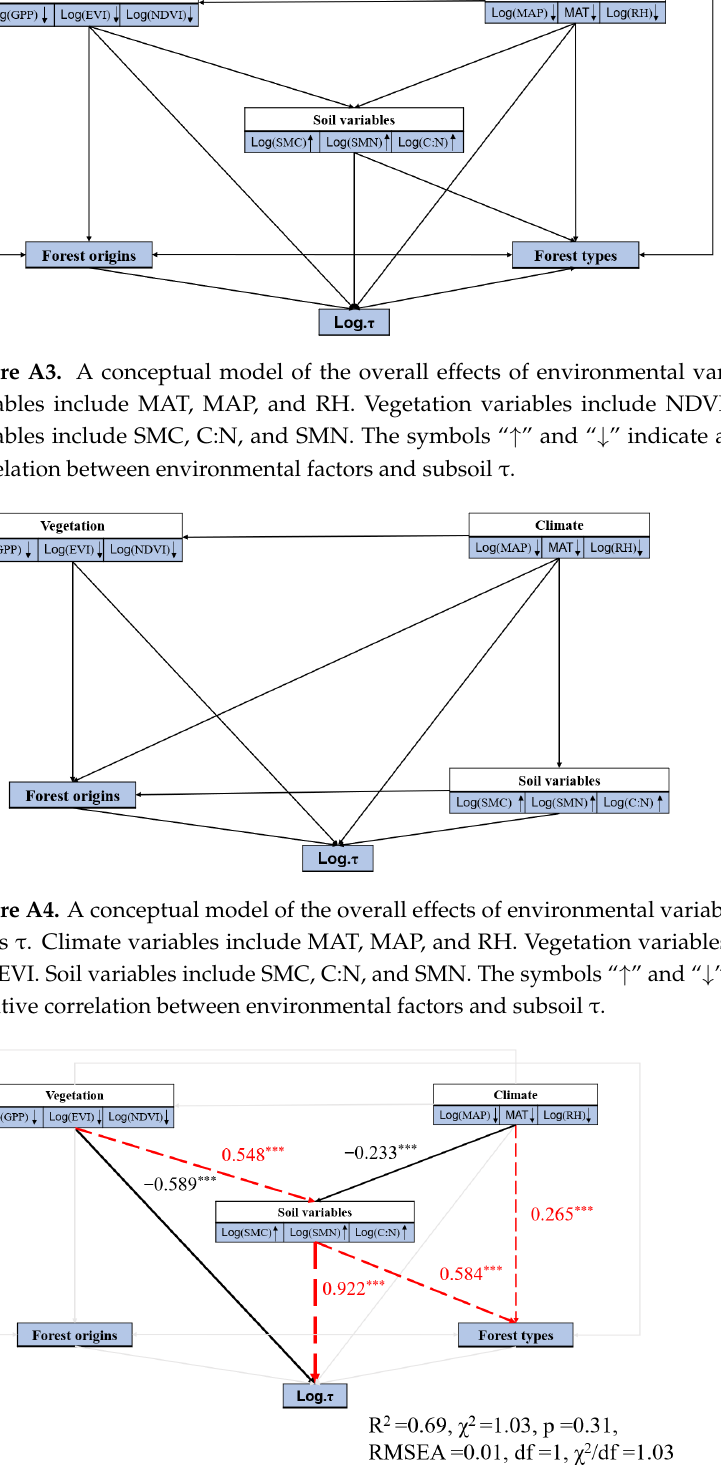
Figure A5. The main influencing factors of C turnover in the subsoil of the boreal zone were obtained by the SEM model. The symbols “ ↑ ” and “ ↓ ” indicate a positive or negative correlation between environmental factors and subsoil τ . The goodness of fit statistics for the effect size model of the relationship are as follows: *** p < 0.001.